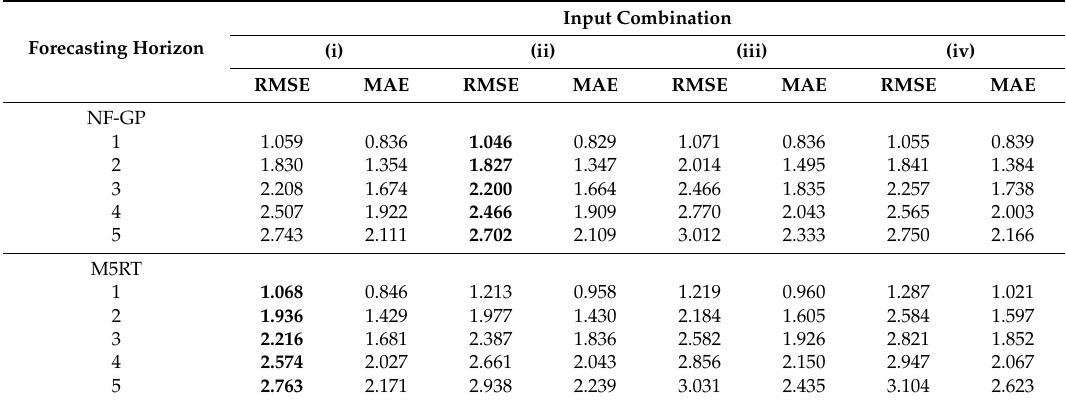
Table 5. NF-GP and M5RT results in wind speed prediction for multiple horizons.